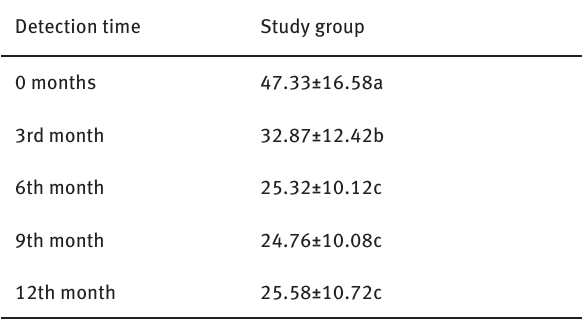
Table 5: Dynamic changes of FeNO concentration in the study group after standardized treatment (